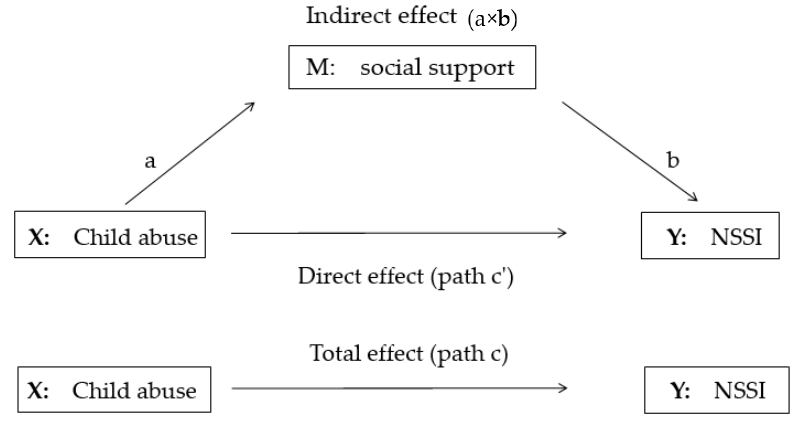
Figure 1. The mediation model.